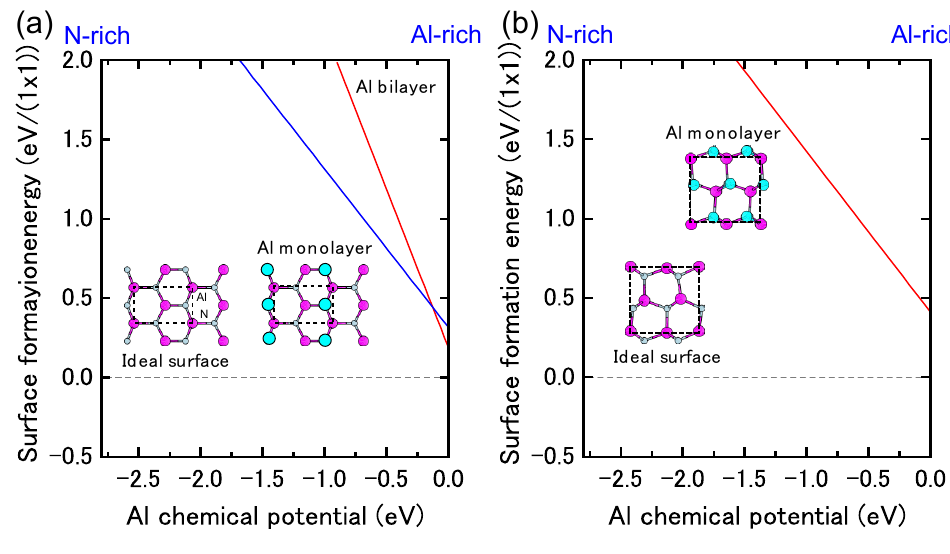
Figure 25. Calculated surface formation energies for polar AlN surfaces with ( a ) (11 _ and ( b ) (112 0) orientations as a function of Al chemical potential. Schematics of the surface structures under consideration are also